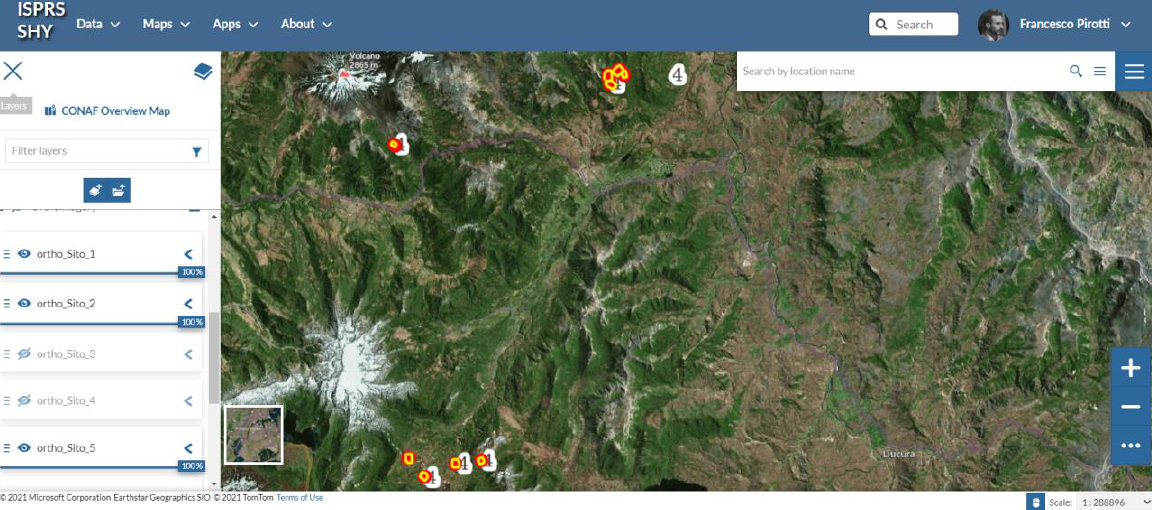
Figure 2. Study areas from one project with several high resolution orthoimages and ground truth